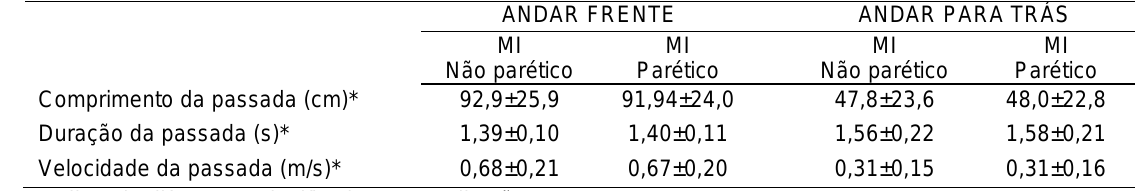
Tabela 2. Resultados de média e desvio-padrão das variáveis espaço-temporais comparando MI não parético e MI parético no AF e